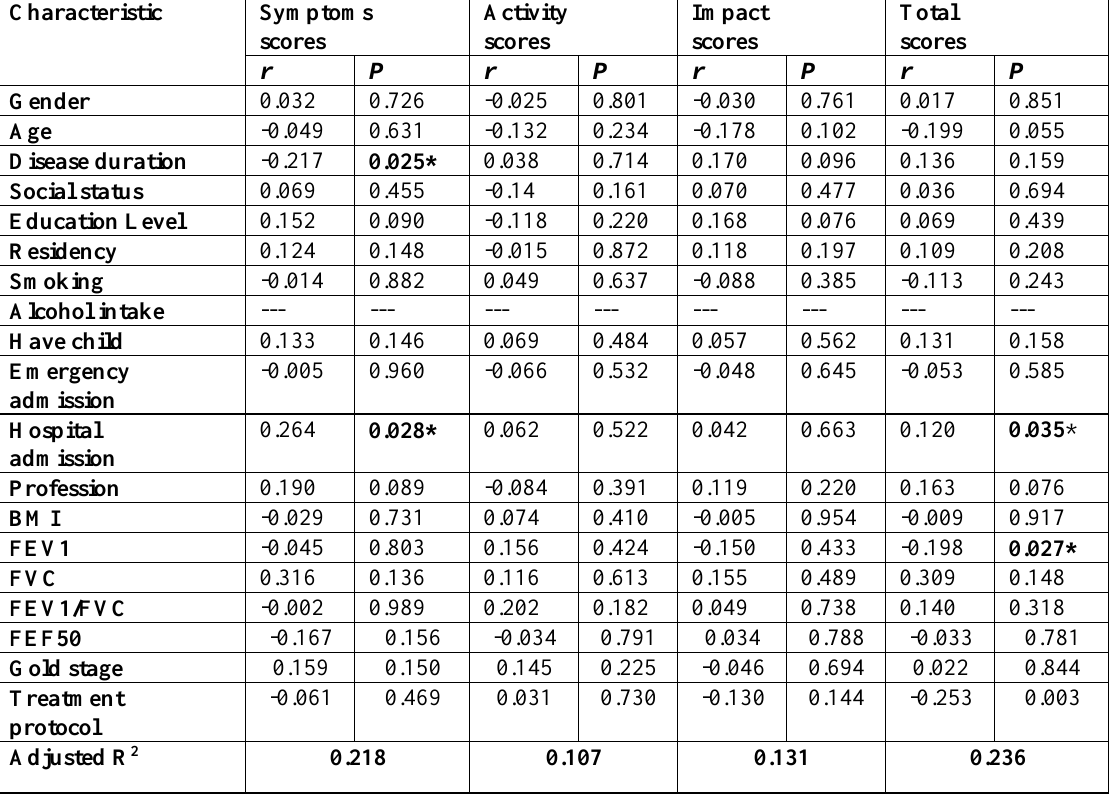
Table 4. Multivariate regression analysis to find the predictors of quality of life score in COPD